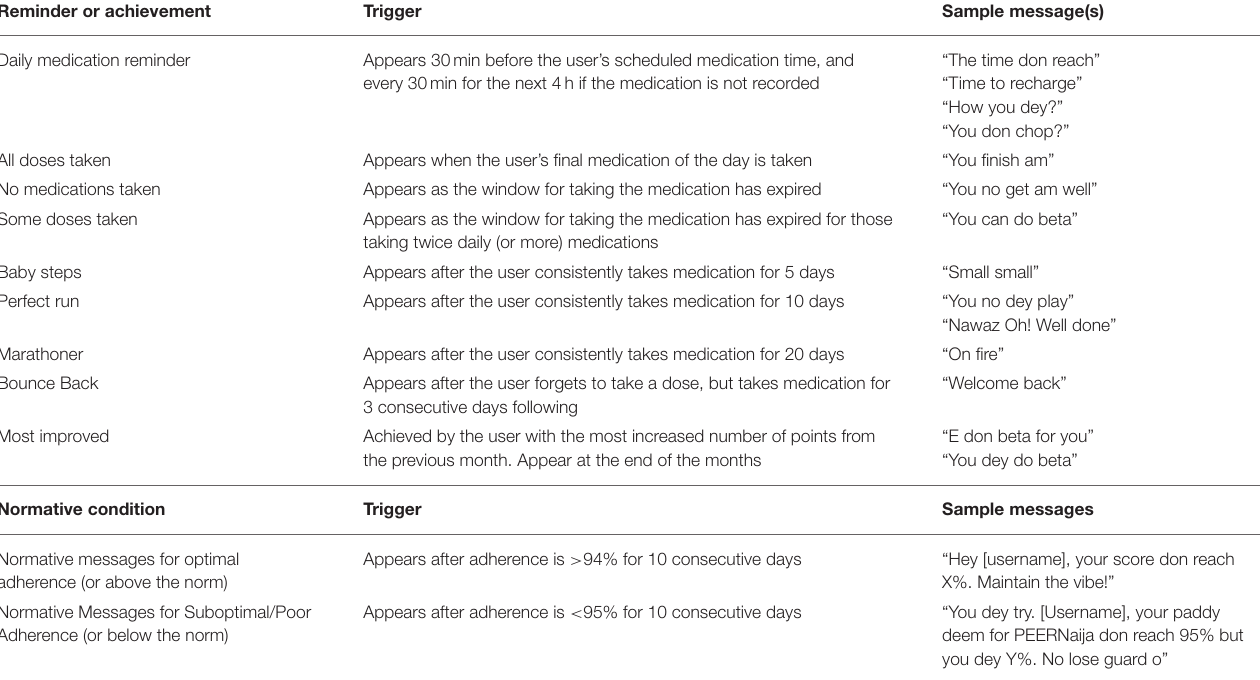
TABLE 2 | Sample achievement and normative-based messages used in PEERNaija . Reminder or achievement